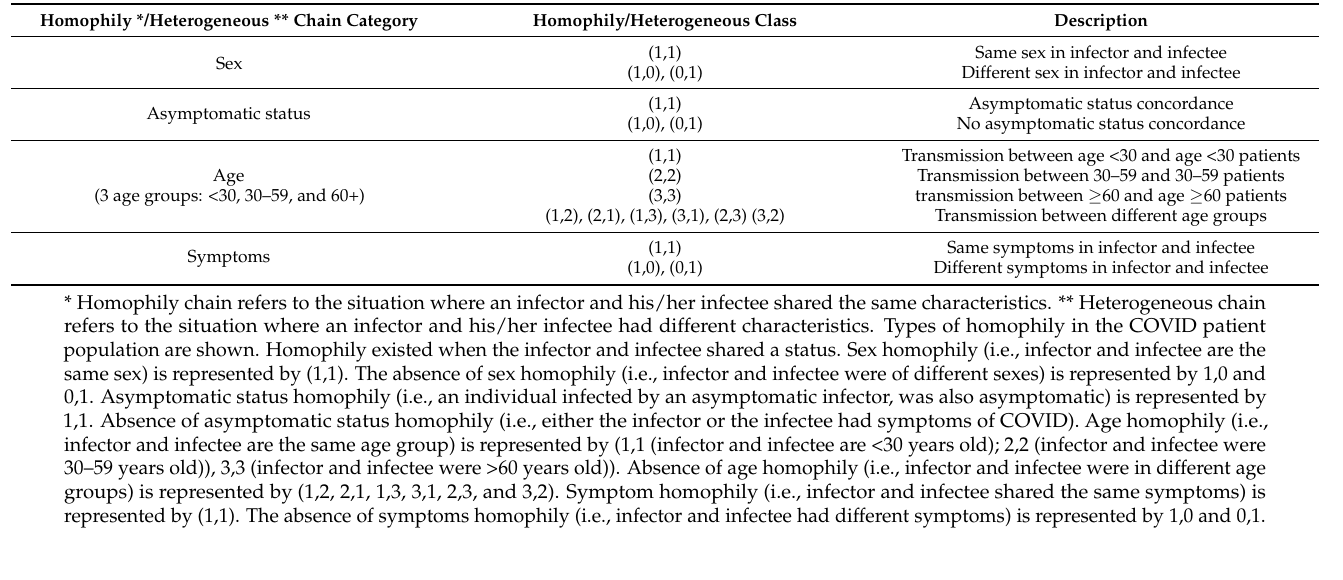
Table 1. Homophily and Heterogeneous Chains and